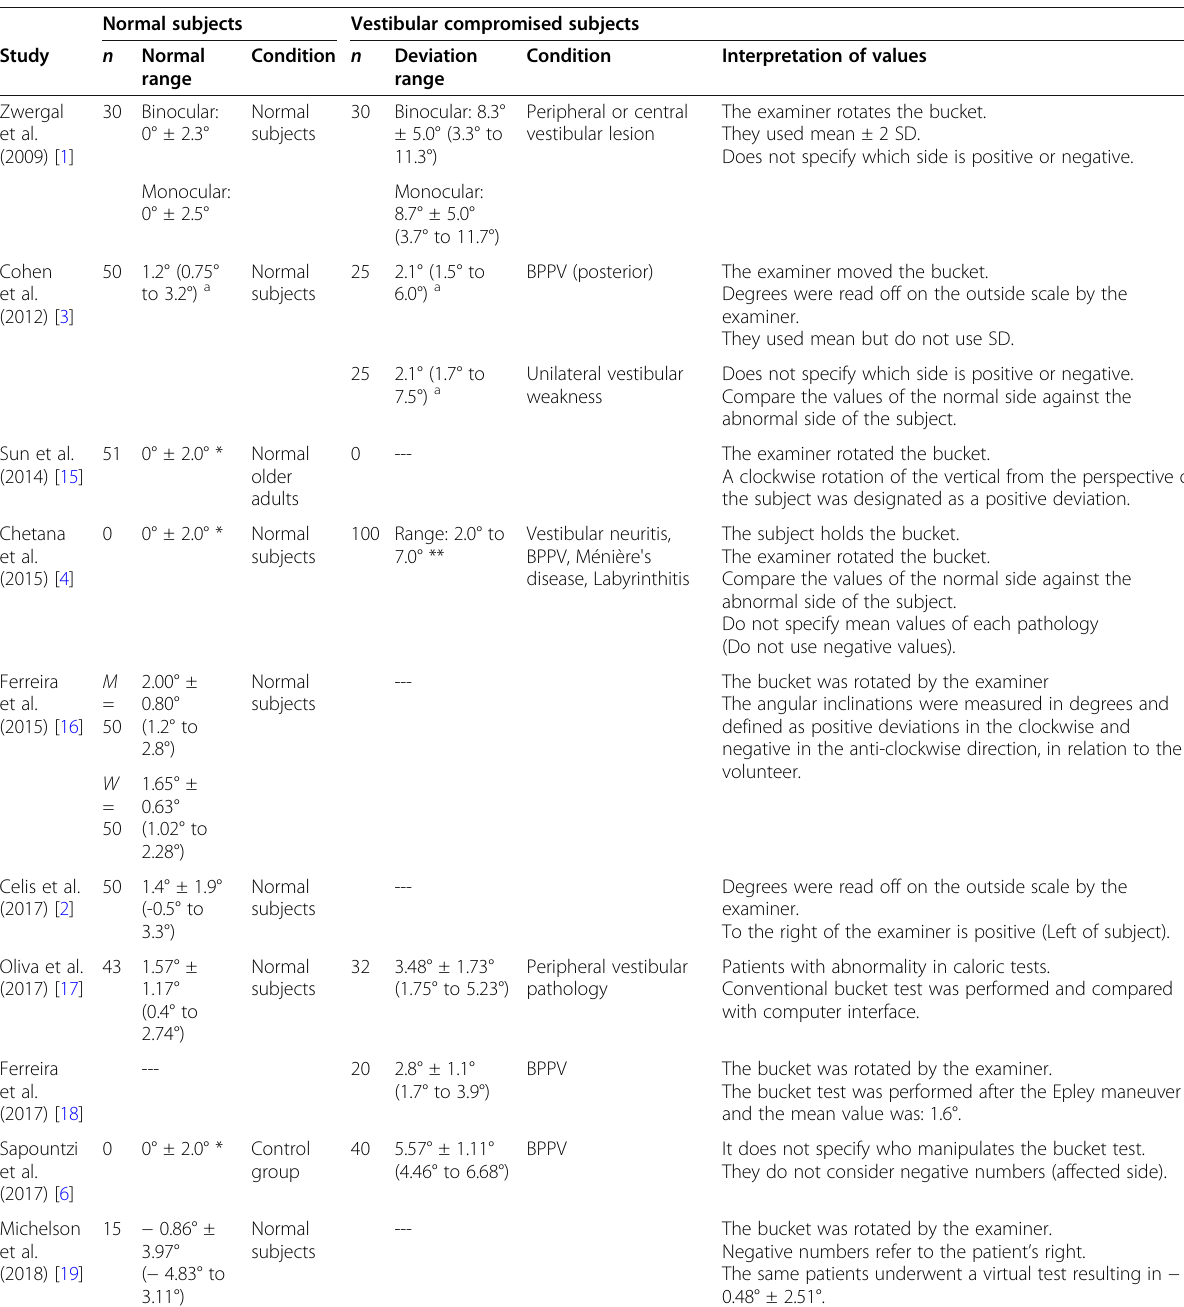
Table 4 Review of previous studies with the use of the “ bucket test ” in patients with vestibular pathologies and in healthy volunteers